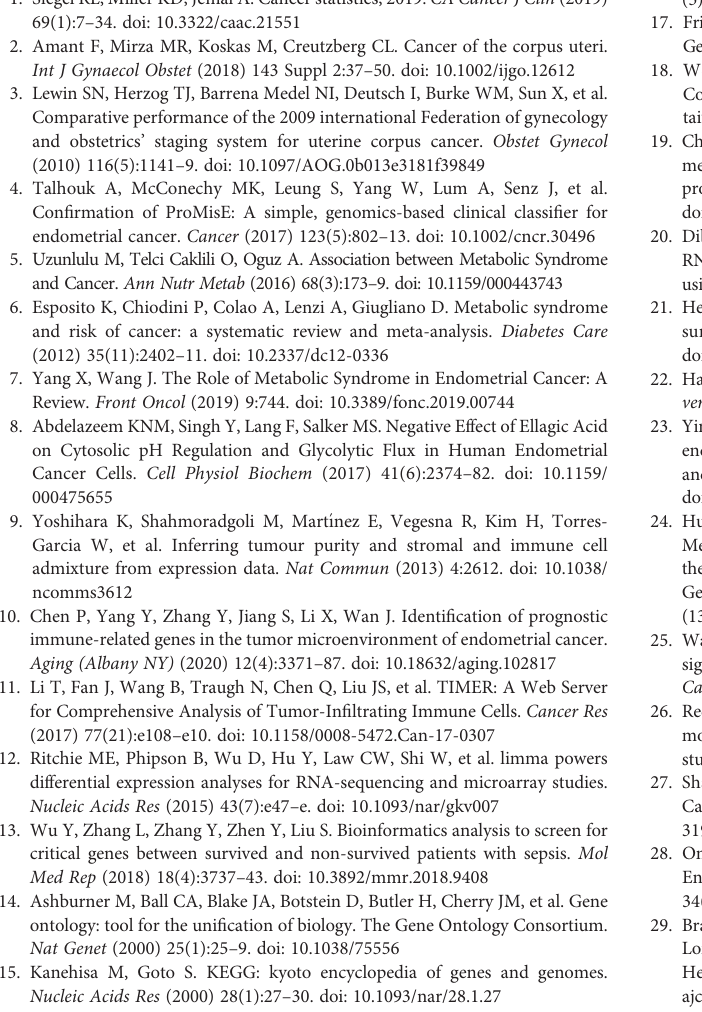
Supplementary Figure 2 | The expression of the metabolism-related genes shown by heatmap in TCGA (A) and GSE17025 (B) , where red and green dots